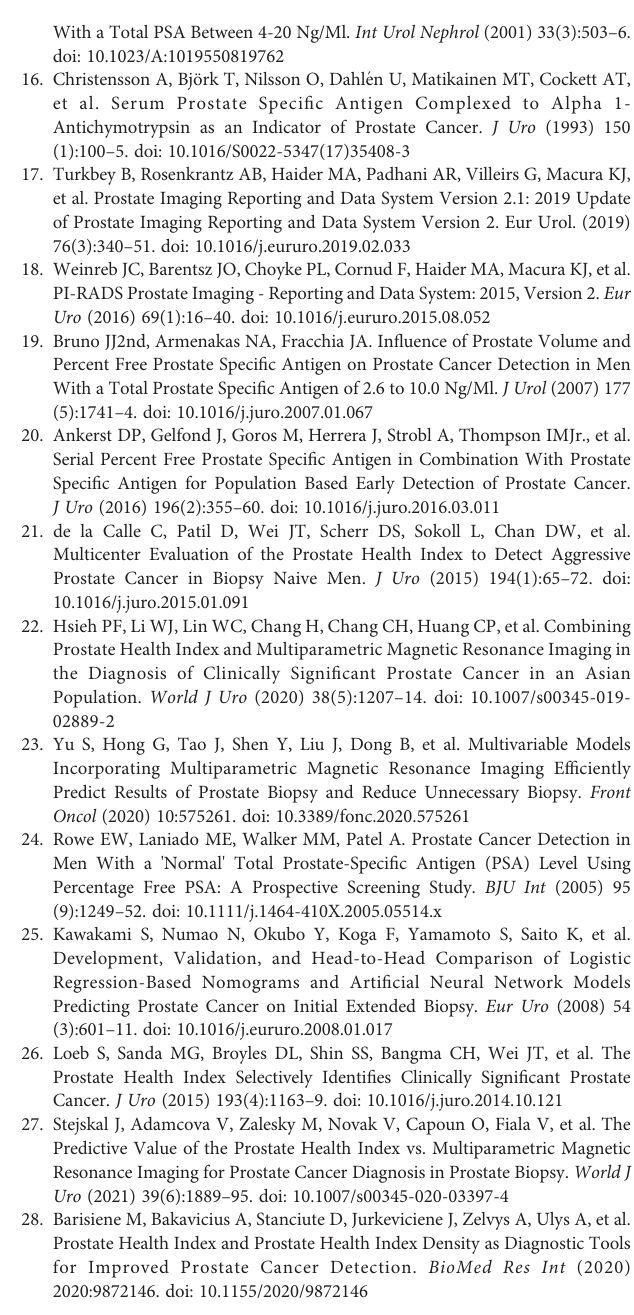
Supplementary Figure 1 | The ROC curves and the curves of correction for multiple comparisons of models. (A) The models for PCa in TPSA 4-10 ng/ml. (B) The models for CSPCa in TPSA 4-10 ng/ml. (C) The models for PCa in TPSA 10-20 ng/ml. (D) The models for CSPCa in TPSA 10-20 ng/ml. (E) The models for PCa in TPSA 4-20 ng/ml. (F) The models for CSPCa in TPSA 4-20 ng/ml. R^1(t): Model A: multivariable model that based on the TPSA derivatives, R^2(t): Model B: multivariable model that based on the combination of PHI derivatives and base model, R^3(t): Model C: multivariable model that based on combination of the PI- RADS and base model, R^4(t): Model D: multivariable model that based on the combination of PHI derivatives and PI-RADS, R^(t): The curve of correction for multiple